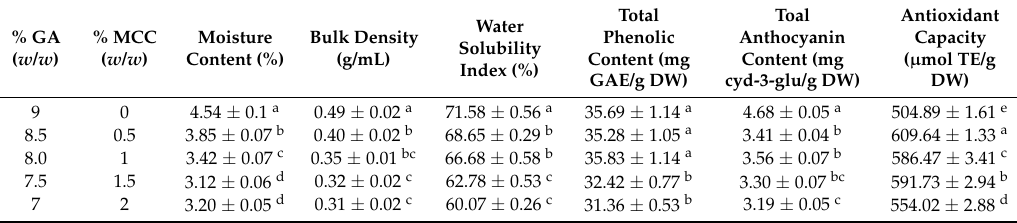
Table 3. Effects of microcrystalline cellulose concentrations on physiochemical properties of instant mulberry